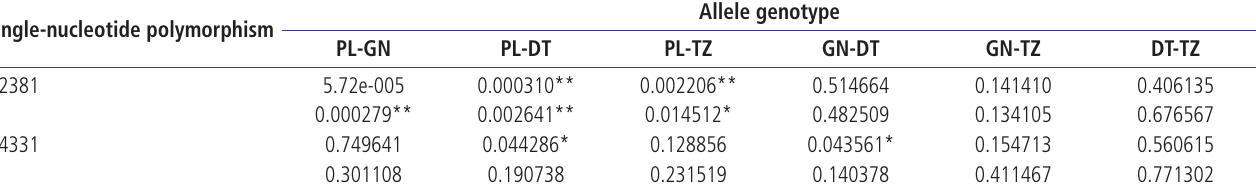
Table 5. Comparison of differences in genotype and allele frequencies Single-nucleotide polymorphism